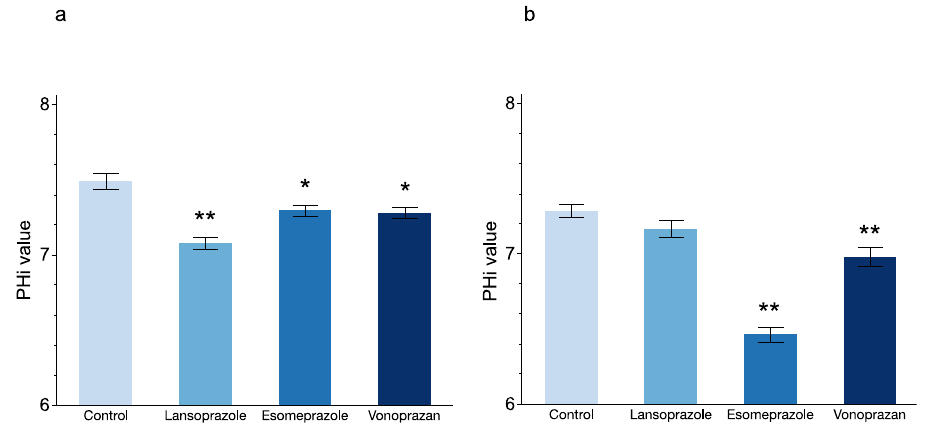
Figure 5. Effect of PPI treatment on intracellular pH. The figure presents the results of intracellular pH measurement of KYSE50 ( a ) and KYSE70 ( b ) cells at 72 h after treatment with sublethal concentrations of PPIs. *: p < 0.05, **: p < 0.01.